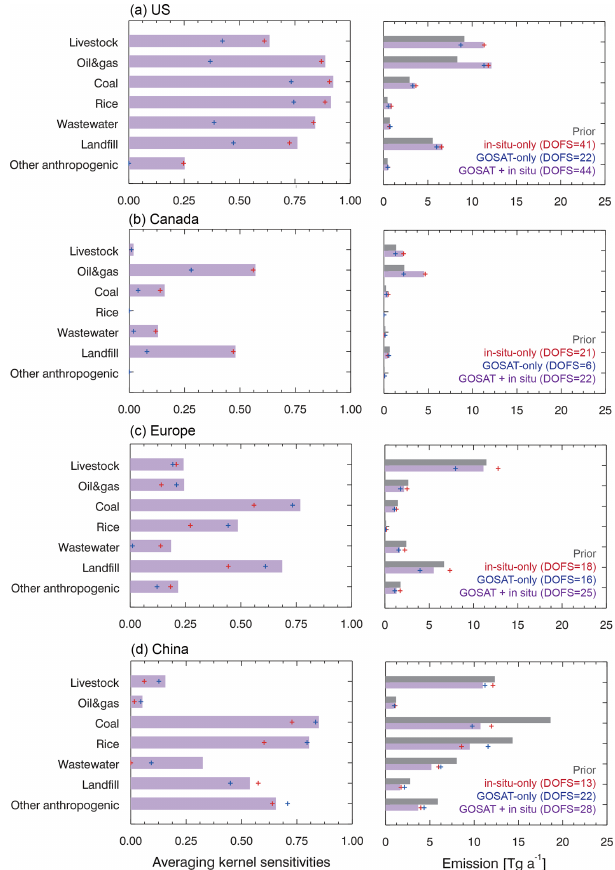
Figure 9. Optimization of anthropogenic methane emissions by source sectors in the in-situ-only, GOSAT-only, and GOSAT + in situ inversions. The left panel shows the averaging kernel sensi- tivities for each emission sector (see text for description), and the right panel shows the emissions. Europe is defined as west of 30 ◦ E, which excludes